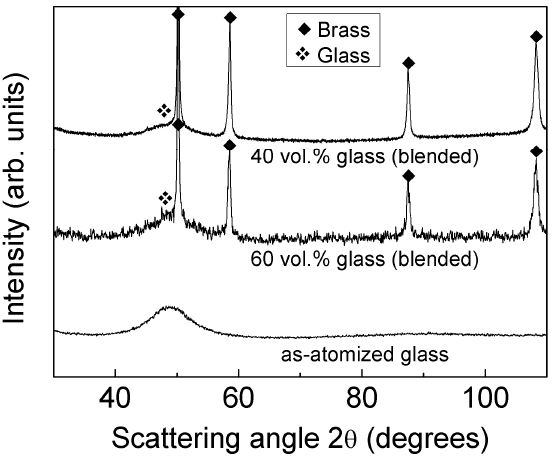
Figure 4. XRD patterns (Co- K α radiation) for the as-atomized Ni and for the consolidated blended composites with 40 and 60 vol.% of glass reinforcement.